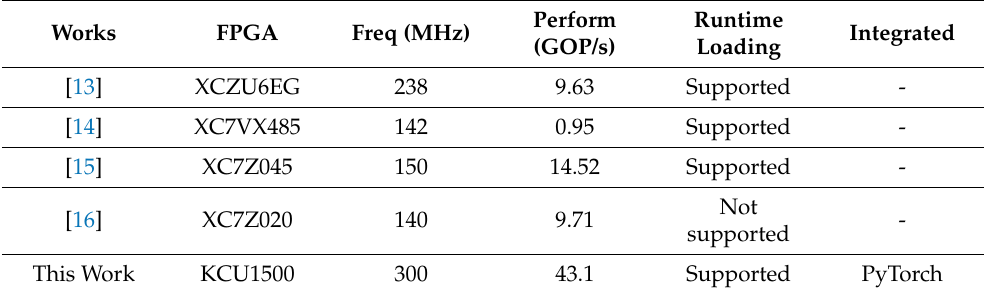
Table 5. Comparison of implementations for LSTM network on